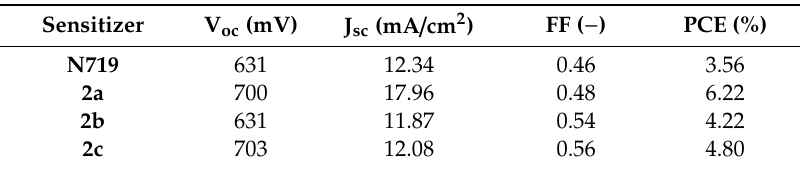
Figure 9. Photocurrent density–voltage (J-V) curves of the prepared devices with dyes 2a–2c. Table 6. The photovoltaic parameters of tested DSSC, based on dyes 2a–2c registered under AM 1.5 G illumination (100 mW/cm 2 ).